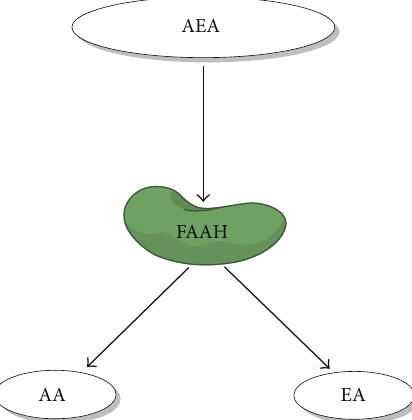
Figure 3: AEA is hydrolysed into arachidonic acid (AA) and etha- nolamine by fatty acid amide hydrolase (FAAH).